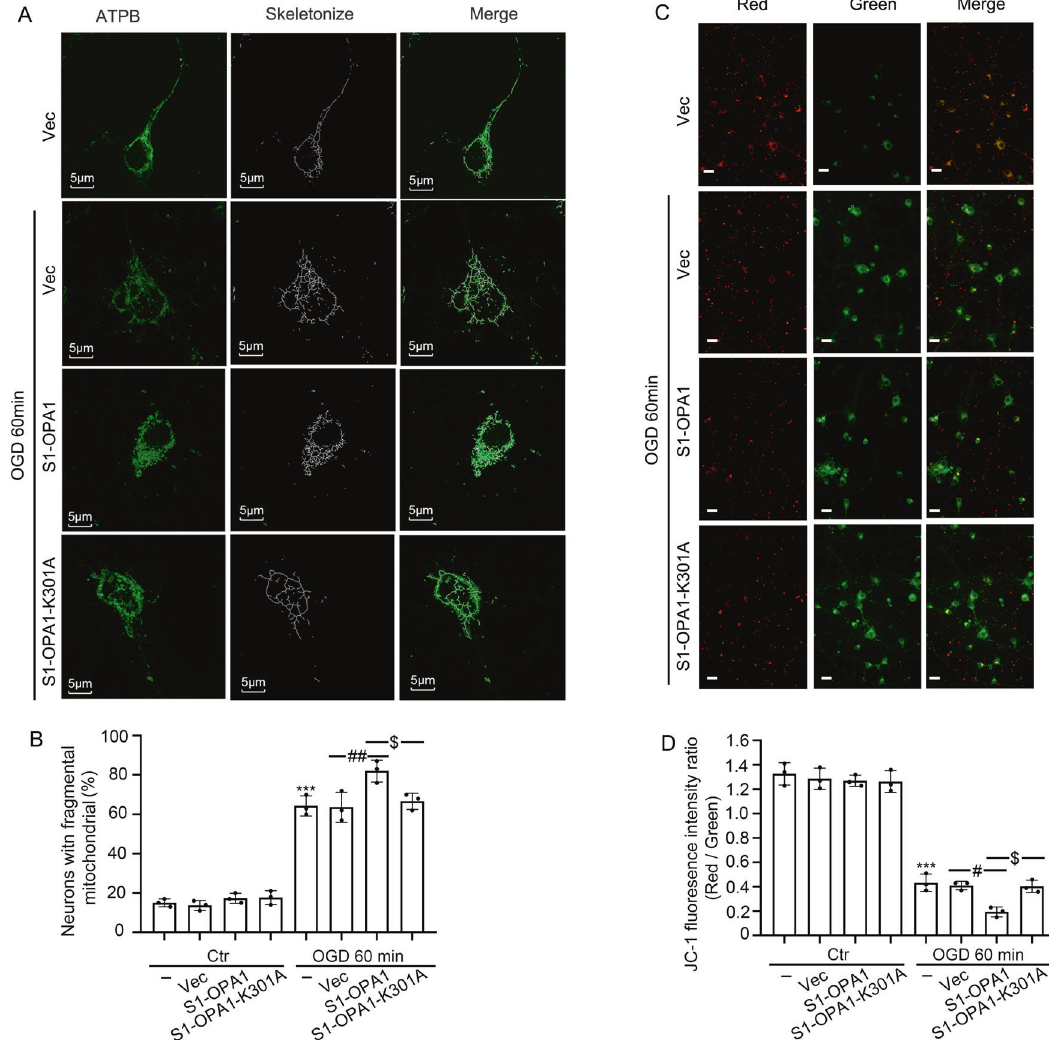
Fig. 2 S1-OPA1 overexpression exacerbated mitochondrial fragmentation and membrane potential damage after OGD. A Representative confocal images of mitochondrial morphologies in different overexpression groups under normal condition and OGD for 60 min. Scale bar = 5 μ m. B Representative quantitative results of the percentage of neurons with fragmented mitochondria. C Representative images of JC-1 fl uorescence staining in different overexpression groups under normal condition and OGD for 60 min. Scale bar = 20 μ m. D Red/green fl uorescence ratio was used to indicate reduced mitochondrial membrane potential. *** p < 0.001 vs. control group, ## p < 0.01, # p < 0.05, $ p < 0.05, n =